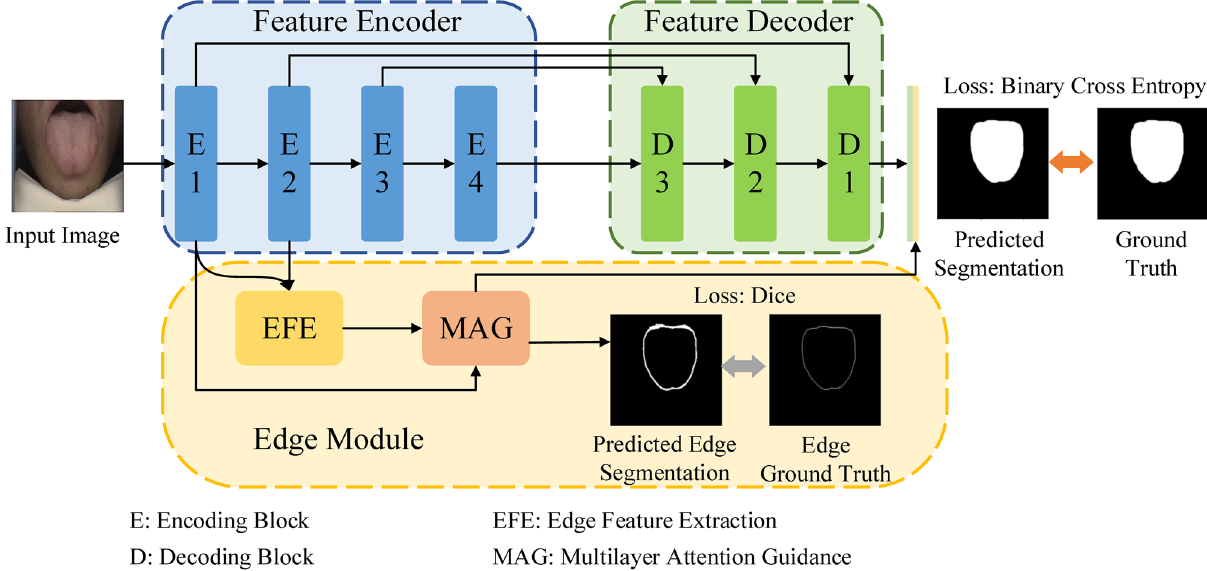
Figure 1. Overview of the MEA-Net (a feature encoder, a feature decoder, and an edge